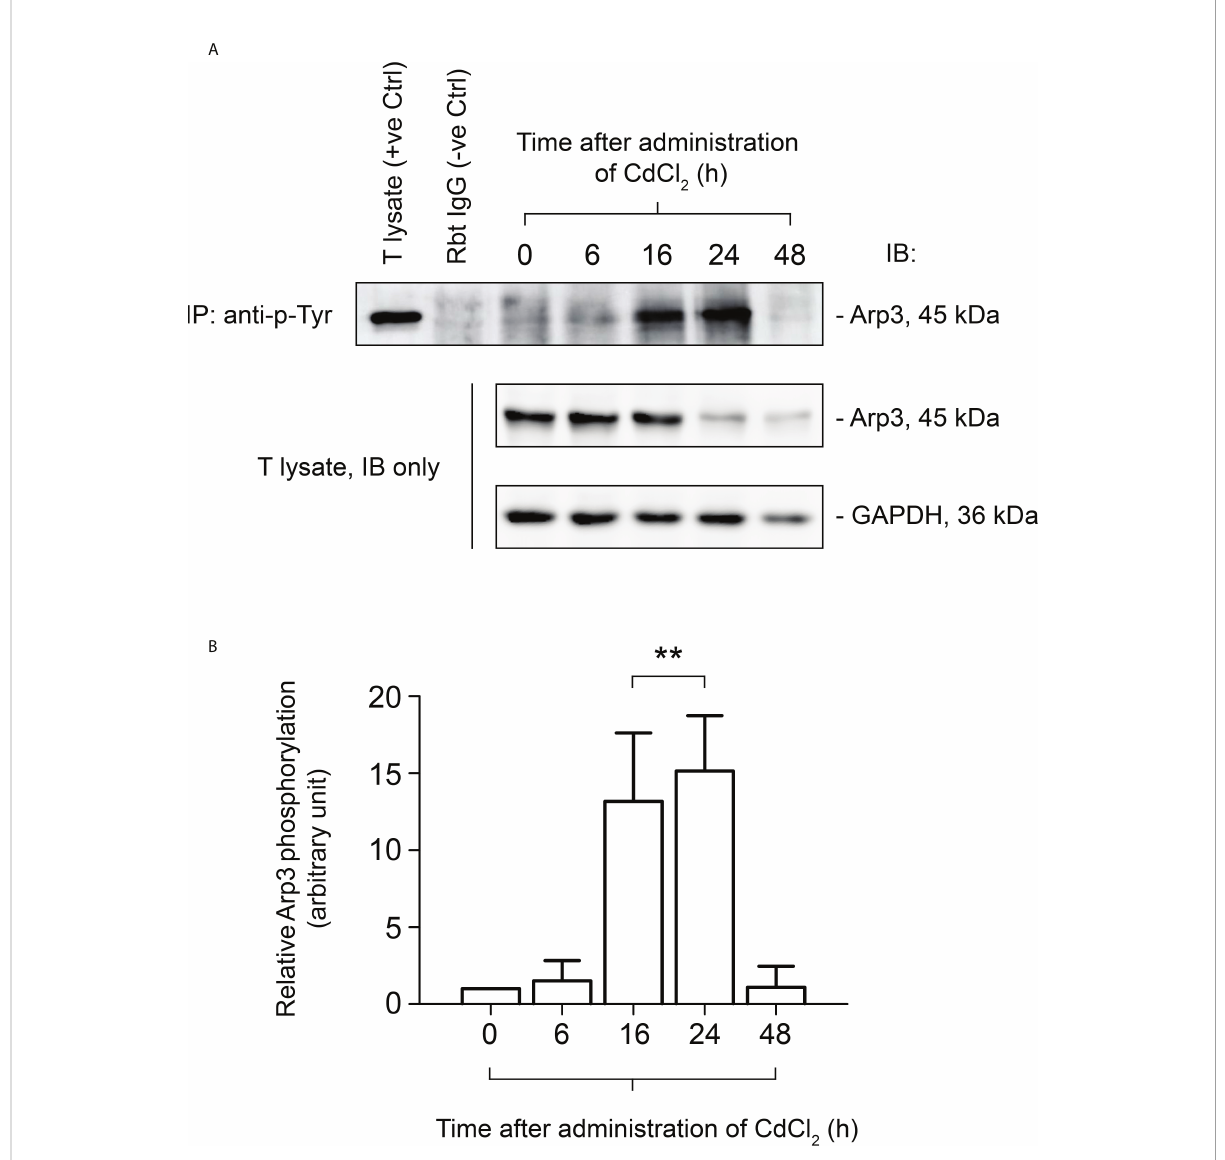
FIGURE 6 Co-immunoprecipitation (Co-IP) study to evaluate the tyrosine phosphorylation status of Arp3 during CdCl 2 -induced junctional restructuring. For Co-IP experiments (A) , ~800 µg testis (T) lysate from CdCl 2 -untreated and treated mice was incubated with anti-phosphotyrosine (p-Tyr) antibody, followed by immunoblotting (IB) with an Arp3 antibody (Table 1). The level of Arp3 in response to CdCl 2 administration was also shown. GAPDH served as an internal control. (B) A histogram summarizing the results of Co-IP. The tyrosine-phosphorylated Arp3 level at 0 hour was arbitrarily set at 1. Each bar represents the mean ± S.D. of three independent experiments. **P<0.01 by one-way ANOVA with Dunnett ’ s